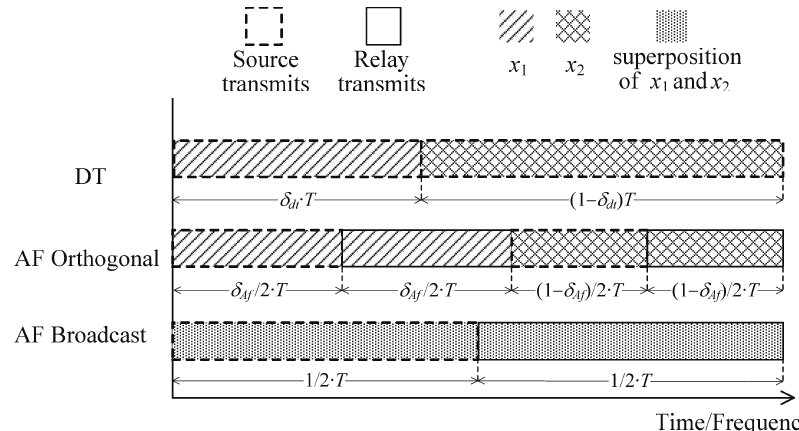
Figure 2. Comparison between the cooperative broadcast transmission and conventional transmission schemes when assigning orthogonal channels to different